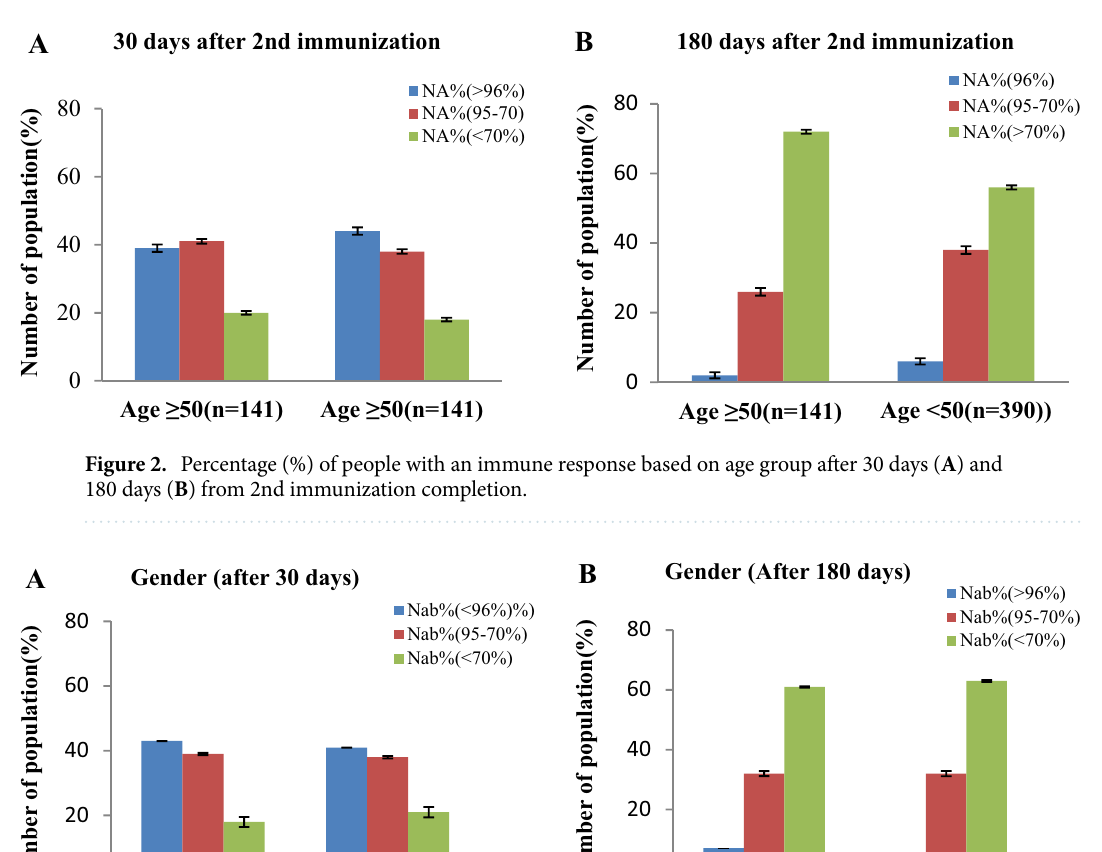
Figure 3. Percentage (%) of people with immune responses based on sex after 30 days ( A ) and 180 days ( B ) of 2nd immunization